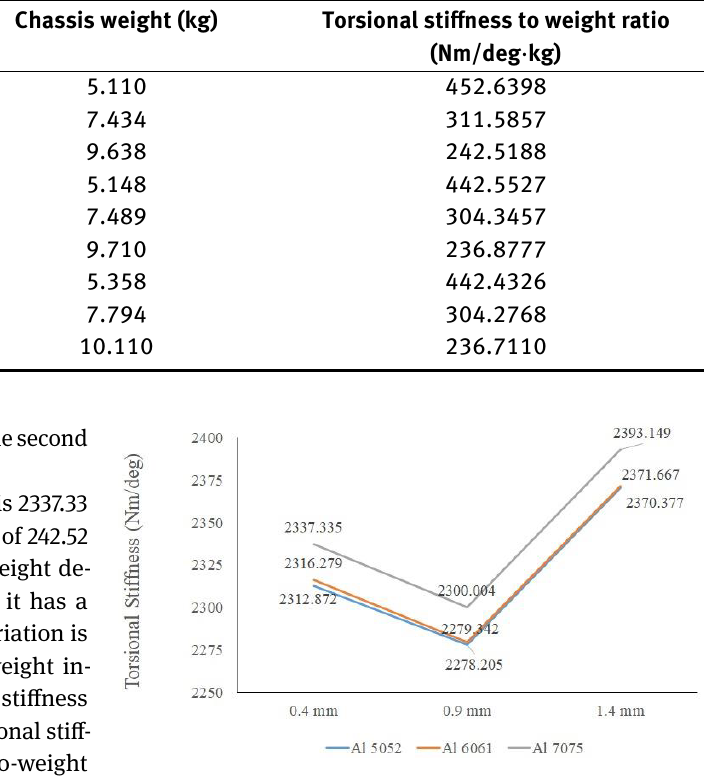
Figure 21: Relationship between chassis thickness and material type with the torsional stiffness